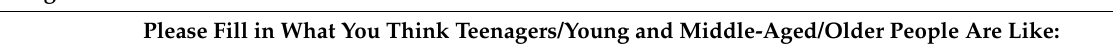
Table 3. Intergenerational Attitudes Scale.